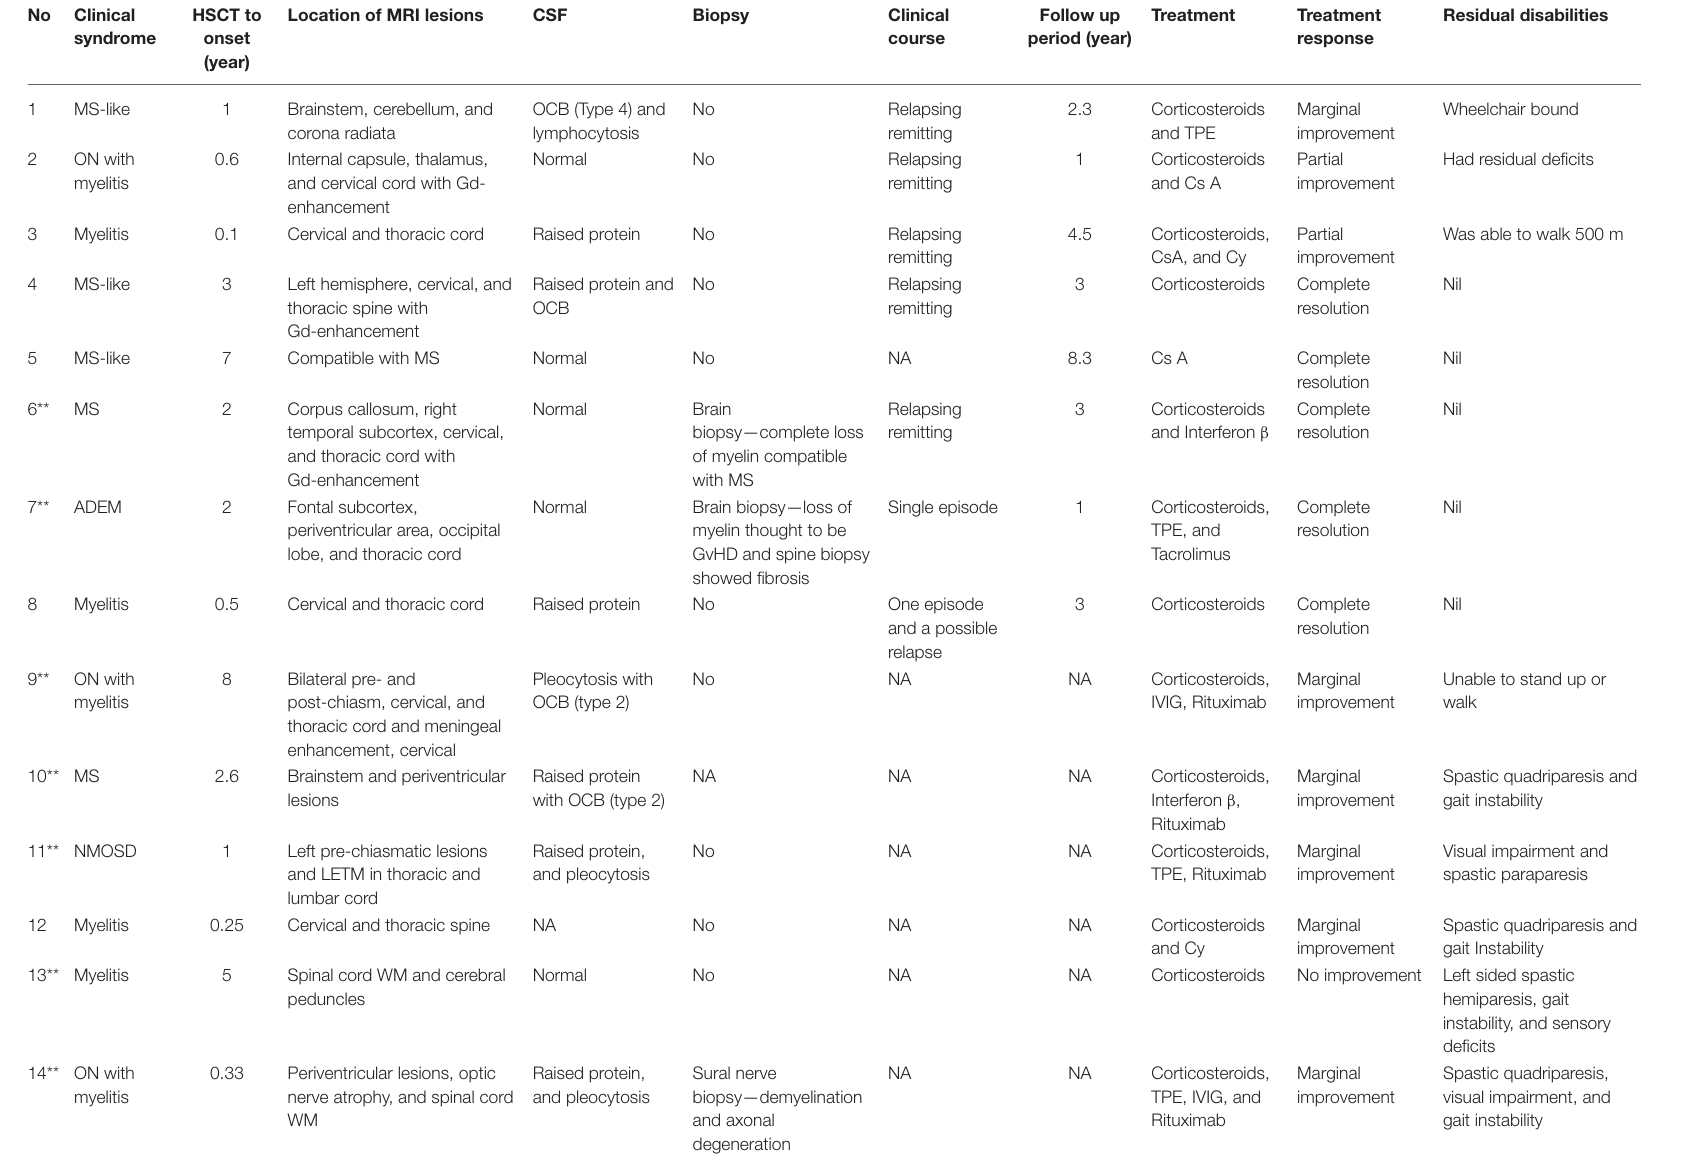
TABLE 2 | Clinical features, investigation results and treatment outcomes of post-transplant CNS demyelinating disorders. No Clinical